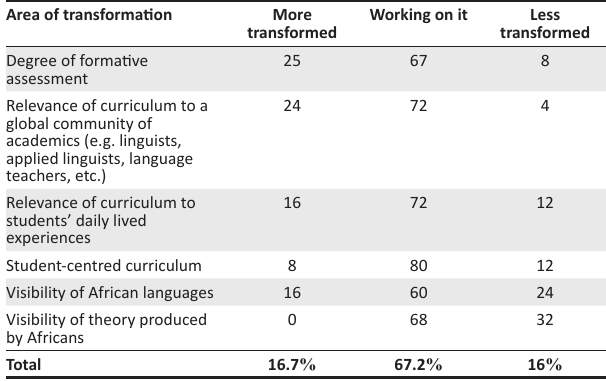
TABLE 3: Degree to which transformation is perceived as having been achieved.